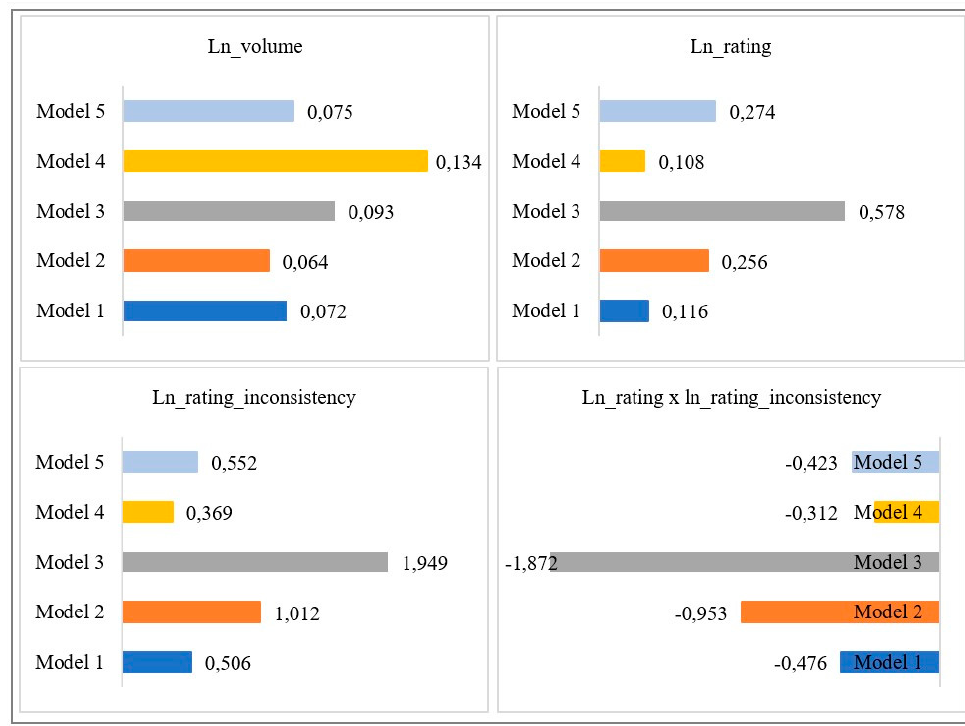
Figure 3. Review non-textual variables' coefficients in system GMM models. Figure 3. Non-textual product variables coefficients in system GMM